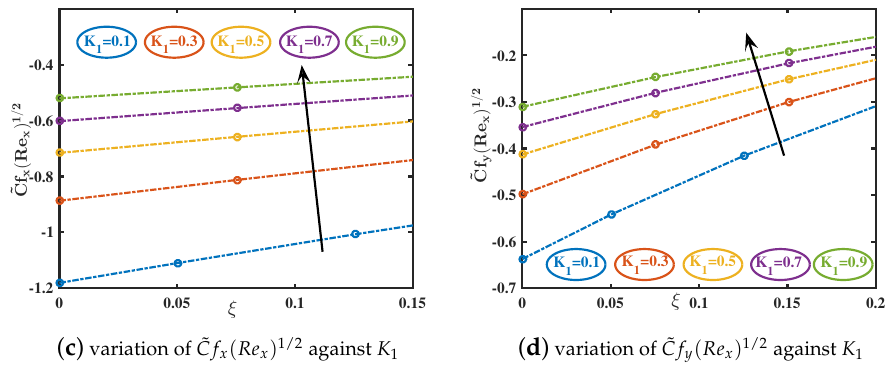
Figure 11. Variations in ˜ Cf x ( Re x ) 1/2 and Cf y ( Re x ) 1/2 trend for different values of M and K 1 .